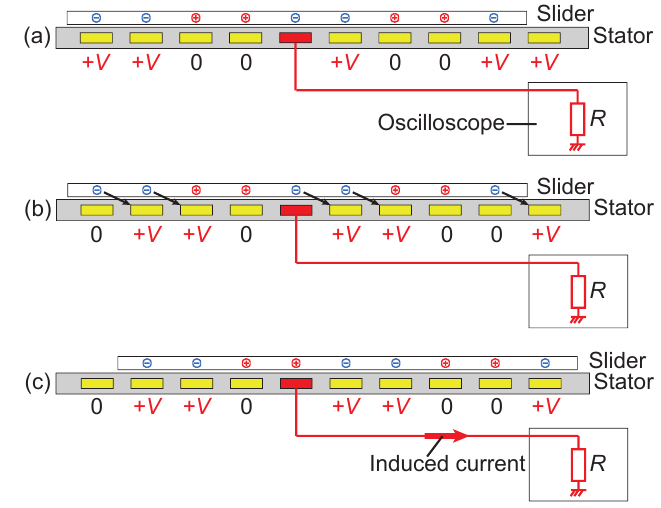
Figure 3. The slider detection method analyzed in this work. The red electrode is utilized as a sensing electrode. The induced current is monitored by an oscilloscope to detect the slider motion over the sensing electrode. ( a ) A charged slider is on the stator surface; ( b ) the stator voltages are shifted; ( c ) the slider moves and the charges on the slider induce current in the sensing